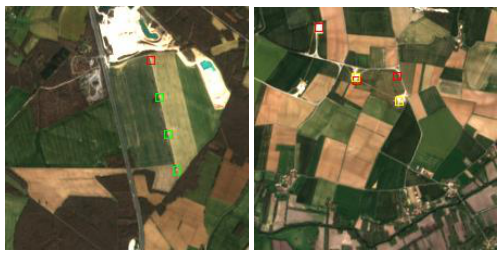
Figure 11 . Limited results of